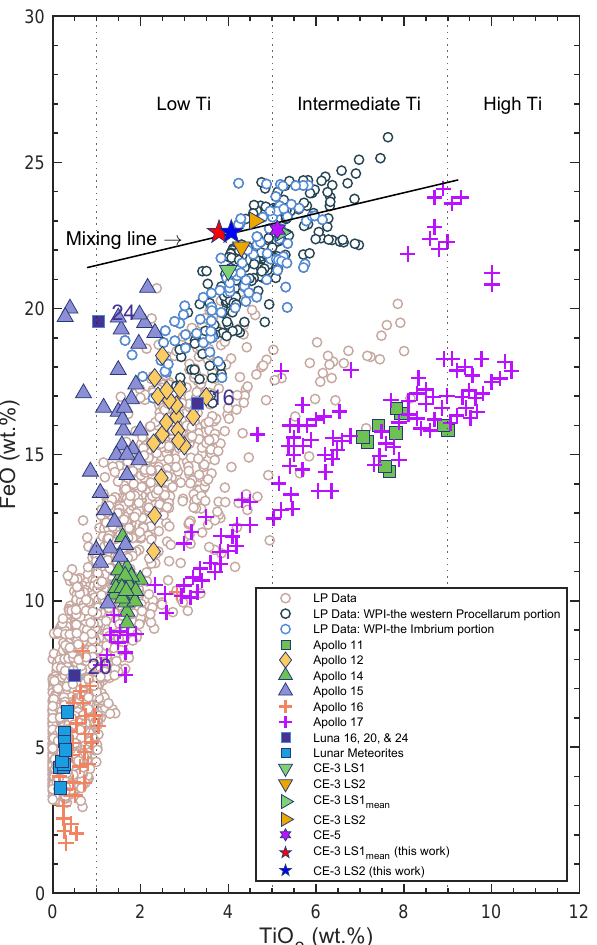
Figure 14. Scatter plot (FeO versus TiO 2 ). In addition to similar indications to Figure 12, within the western Procellarum and Imbrium (WPI, cf. Prettyman et al., 2006 [10]), the portion of Imbrium and the portion of western Procellarum denote as blue and black dots, respectively. As seen in the plot, the Apollo 17 data deviate from the main trend established by LP-GRS data. This is due to the presence of a unique type of lunar rock known as the “orange soil”, which is believed to be a type of volcanic glass that was formed by gas-charged fire fountain volcanic eruptions [2,3,49,51–55]. From the K 2 O concentrations, one can obtain the Th concentrations of 2.59–2.80 ppm using the linear relationship of Th = K − 120.7 ppm [10]. As shown in Figure 15, one can 365.6 and Imbrium (WPI) of LP-GRS data is close to Apollo 12 data. Also, CE-3 data are more close to the portion of western Procellarum within WPI data, as denoted by black